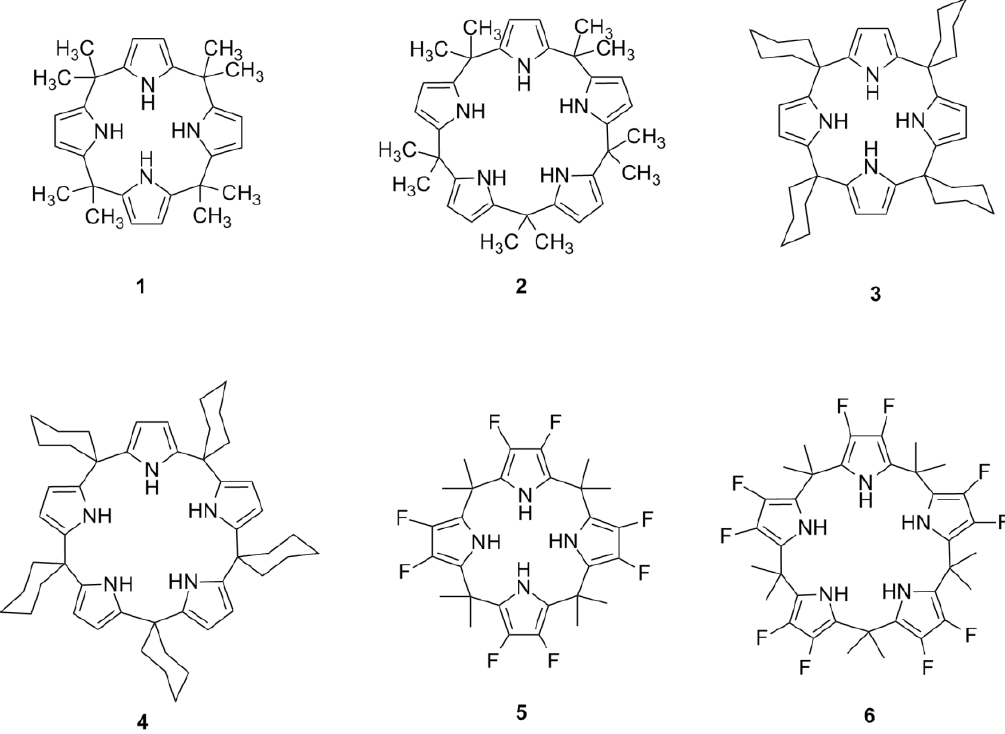
Figure 1. Example of calix[4]pyrroles and